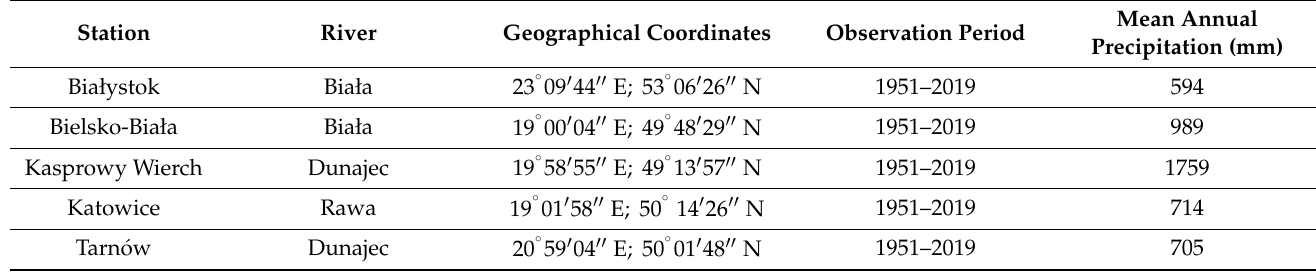
Table 1. Precipitation characteristics in selected meteorological